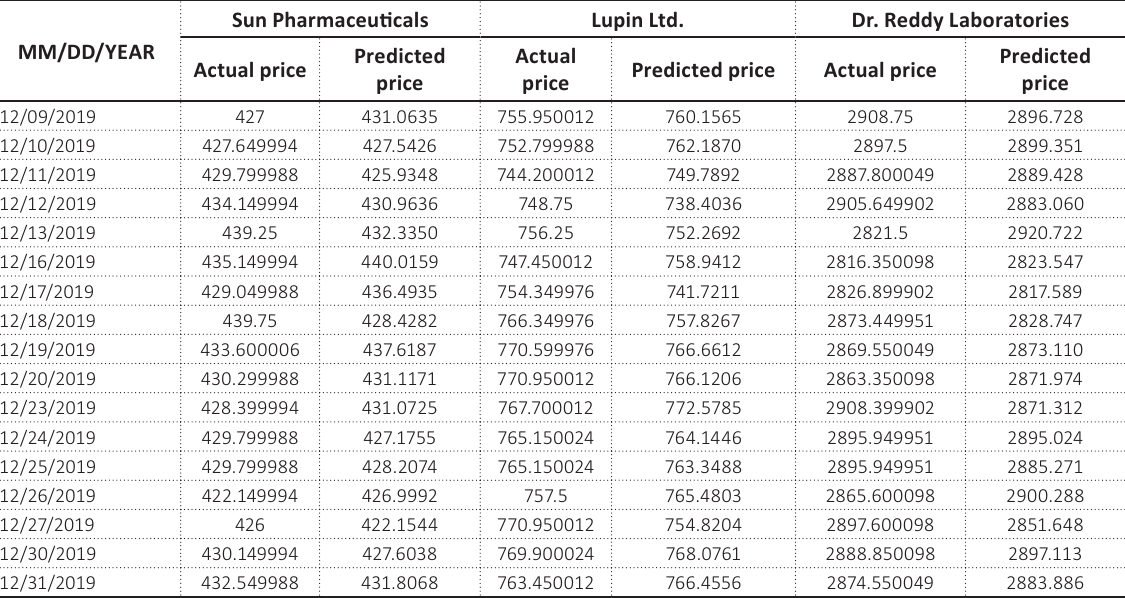
Table A1 (cont.). Actual and forecasted prices of Sun Pharmaceutical Industries Ltd., Lupin Ltd.